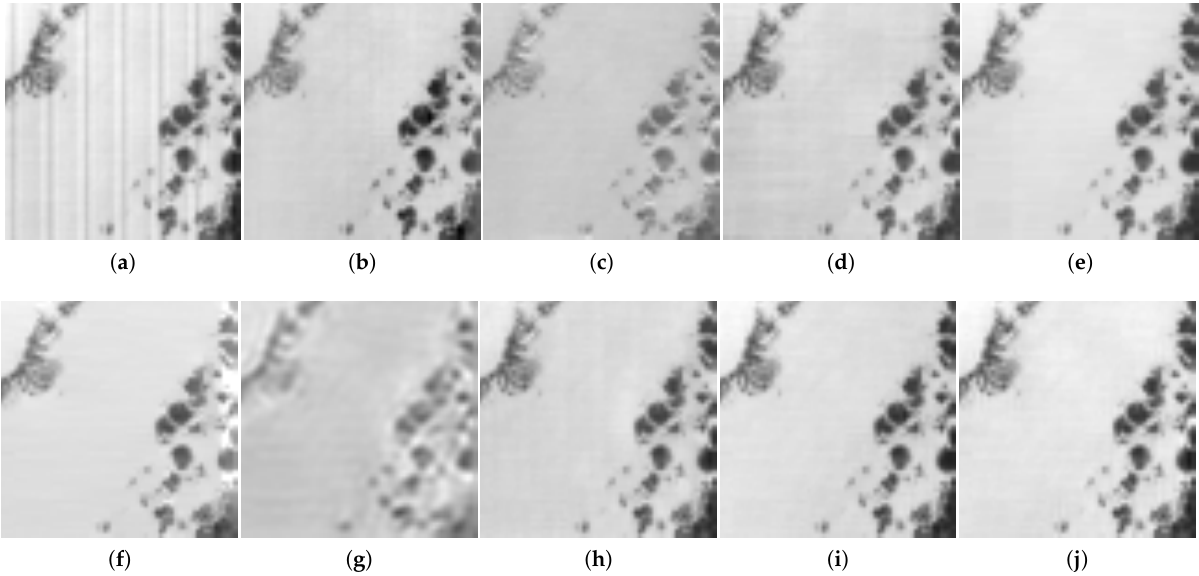
Figure 13. Zoomed results of Figure 12. ( a ) Original image, ( b ) MM, ( c ) ASSTV, ( d ) LRSID, ( e ) the method of [43], ( f ) PADMM, ( g ) ICSRN, ( h ) SSGN, ( i ) TSWEU, ( j )